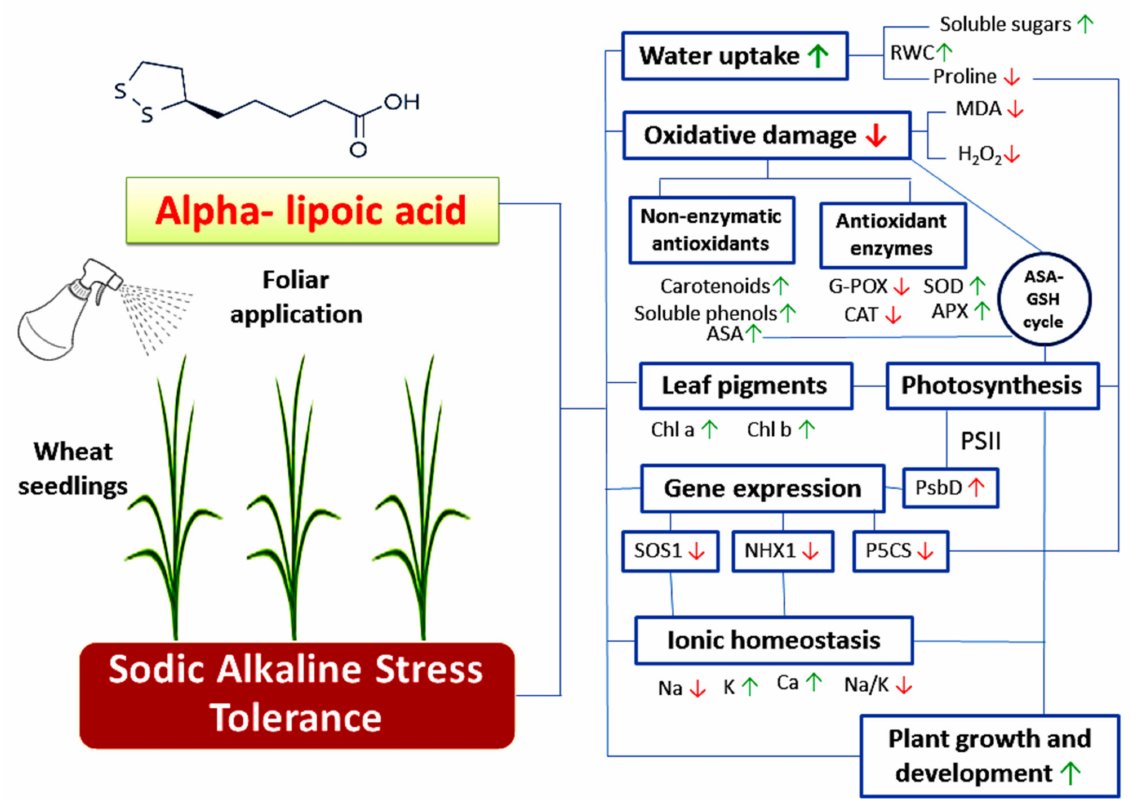
Figure 8. A summary for the induction of sodic alkaline stress tolerance in wheat seedlings by exoge- nous application of α -lipoic acid. Arrows up and down refer to upregulation and downregulation of various studied aspects